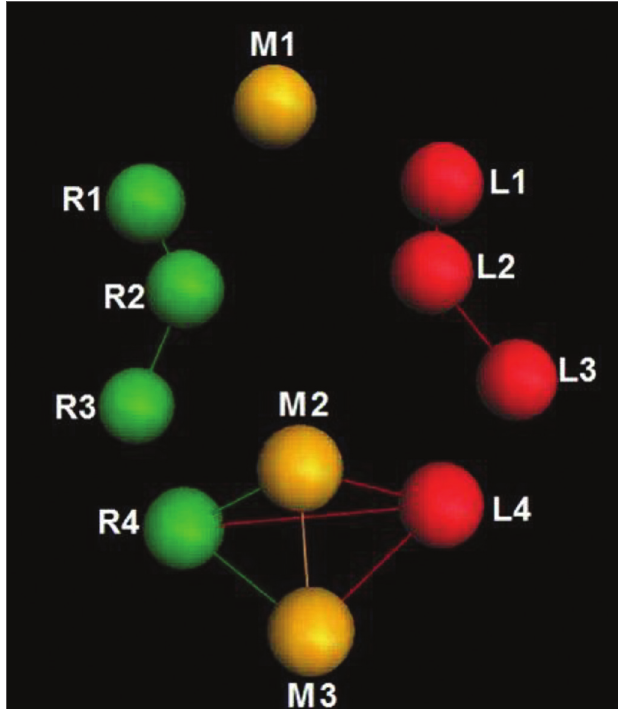
Figura 4. Marcadores estabelecidos com os seus respectivos